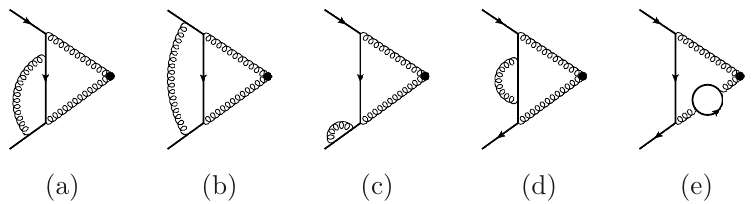
Figure 2 . The two-loop Feynman diagrams for the quark scattering by the ( G µν ) 2 vertex (black circle) which contribute in the next-to-leading logarithmic approximation. Symmetric diagrams are not